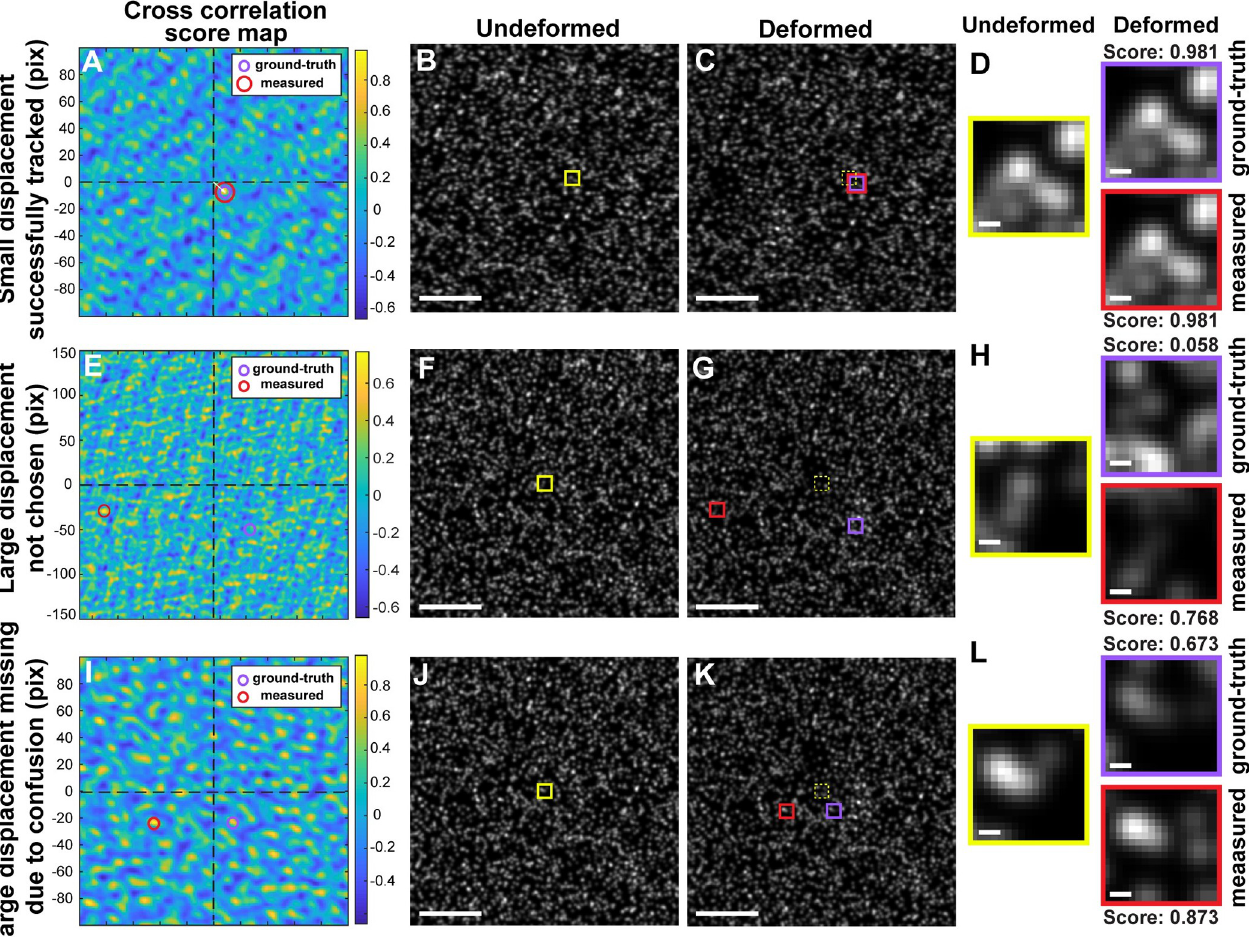
Fig 2. Large displacement shows a correlation score smaller than global correlation maximum. (A-L) Cross correlation score maps (A, E, I), the synthetic reference images of the reference (undeformed) configuration with a yellow box indicating the template window around the center position of a bead of interest (B,F,J), the bead images of the deformed configuration with a red box indicating a shifted location of the measured displacement, a purple box indicating a shifted location of the ground-truth displacement, and a dotted white box indicating the original unshifted position of the template window (C,G,K), and the cropped and enlarged views of the templates with boxes whose color matches those in the bead images (D,H,L) for a small ( < 10 px in magnitude) displacement representative vector (A-D), a large ( > 50 px in magnitude) displacement vector (E-H) and another large (~30 px in magnitude) displacement vector that was determined to be missing